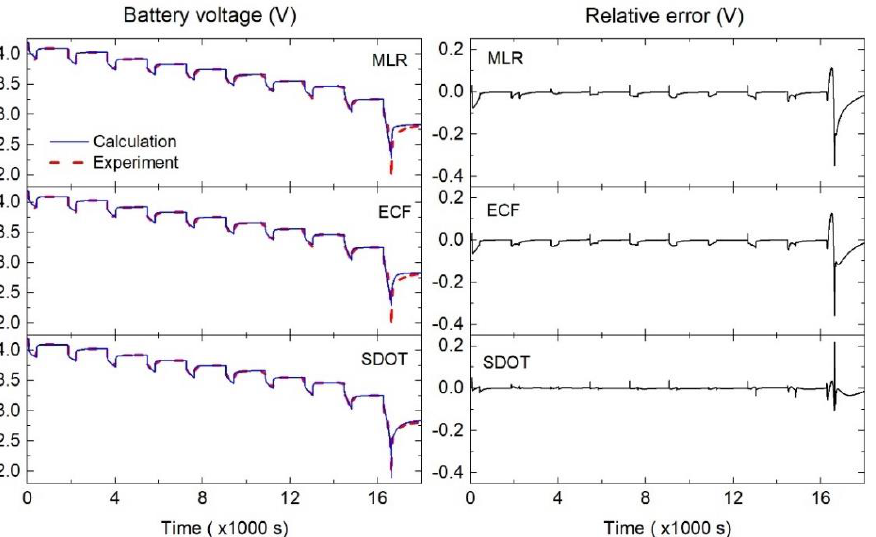
Figure 10. The battery terminal voltage of the pulse discharge test and the relative error for three estimations.